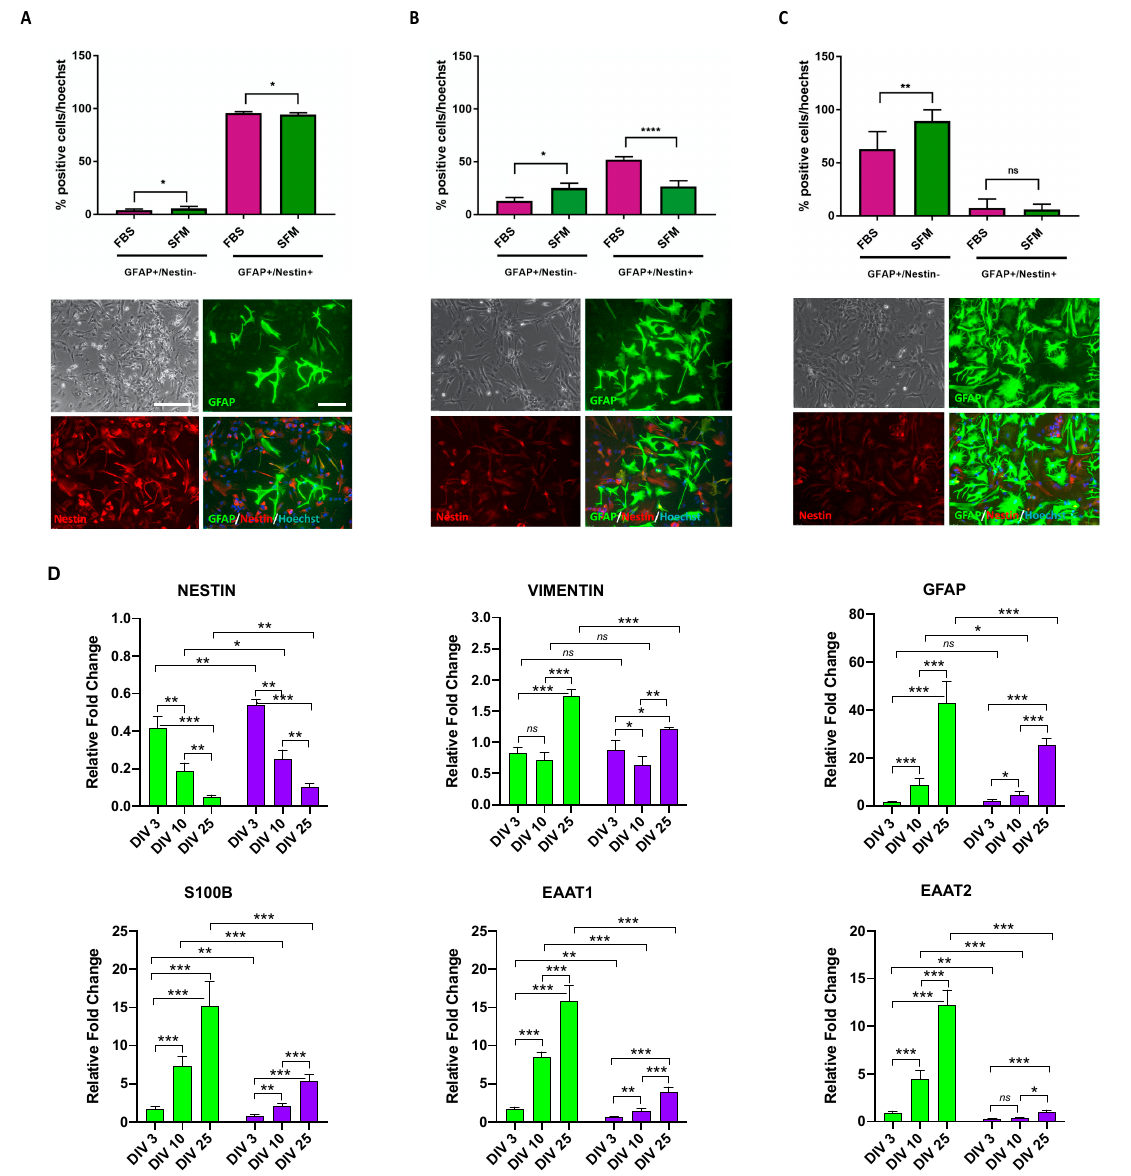
Figure 2. CX APCs derived in ACM-SFM conditions gradually differentiated into CX Astrocytes at DIV 25 of exposure to AMM-SFM or AMM-FBS. ( A – C ) Upper panel: graph showing the percentage of GFAP + /Nestin − (astrocytes) and GFAP + /Nestin + (APCs) cells at DIV 3 ( A ), 10 ( B ) and 25 ( C ) of exposure to AMM-FBS (purple bars) or AMM-SFM (green bars). The percentage was normalized over the total number of cells as assessed by Hoechst staining. Data are expressed as the means ± STDV ( n = 3 biologically independent experiments). p < 0.05 (*), p < 0.01 (**), p < 0.0001 (****) and not significant ( ns ) according to Student’s t-test analysis. Lower panels: Representative phase contrast phase and immunofluorescence pictures of the CX APC cultures exposed for 3 ( A ), 10 ( B ) and 25 ( C ) DIV to AMM-SFM. The fluorescence images are related to the GFAP and Nestin markers and the superimpositions of these are shown. Nuclei are stained with Hoechst. Scale bar: 100 µ m. ( D ) qPCR analysis for NESTIN, VIMENTIN, GFAP, S100B, EAAT1 and EAAT2 transcript levels in hiPSC-derived CX APCs in proliferating SFM conditions and CX APCs exposed for 3, 10 and 25 DIV to astrocyte maturation in SFM (green bars) or FBS (purple bars) conditions. Values were normalized to GAPDH and represent the fold change ratio value related to CX APCs in ACM-SFM (DIV 0). Data are expressed as the means ± STDV ( n = 3 biologically independent experiments). p < 0.05 (*), p < 0.01 (**), p < 0.001 (***) and not significant ( ns ) according to ANOVA and post hoc Tukey